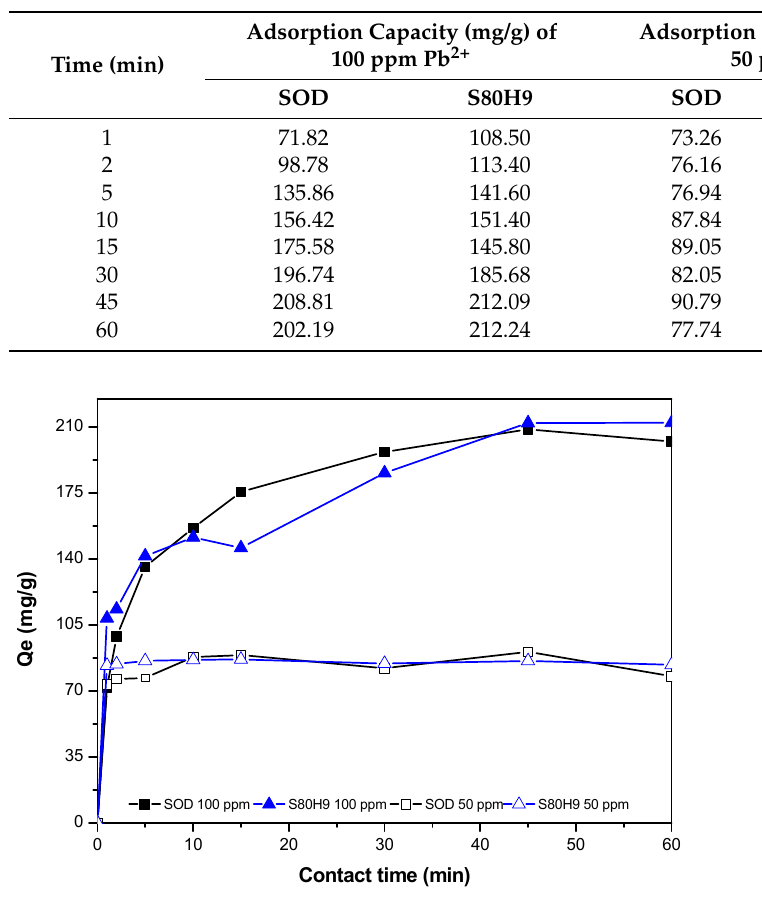
Figure 7. Pb 2+ adsorption on SOD and S80H9 samples.